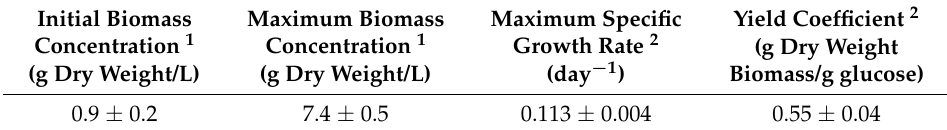
Figure 3. Growth of ∆ XTFT N. benthamiana cell suspension culture in a 1 L shake flask with 200 mL culture volume. The average value and standard deviation from triplicate samples are shown. Table 1. Growth kinetic parameters for ∆ XTFT N. benthamiana shake flask